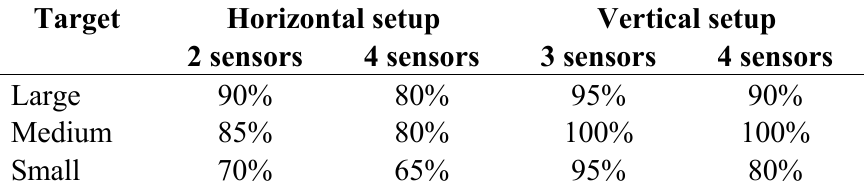
Table 2. The flank localization probability.